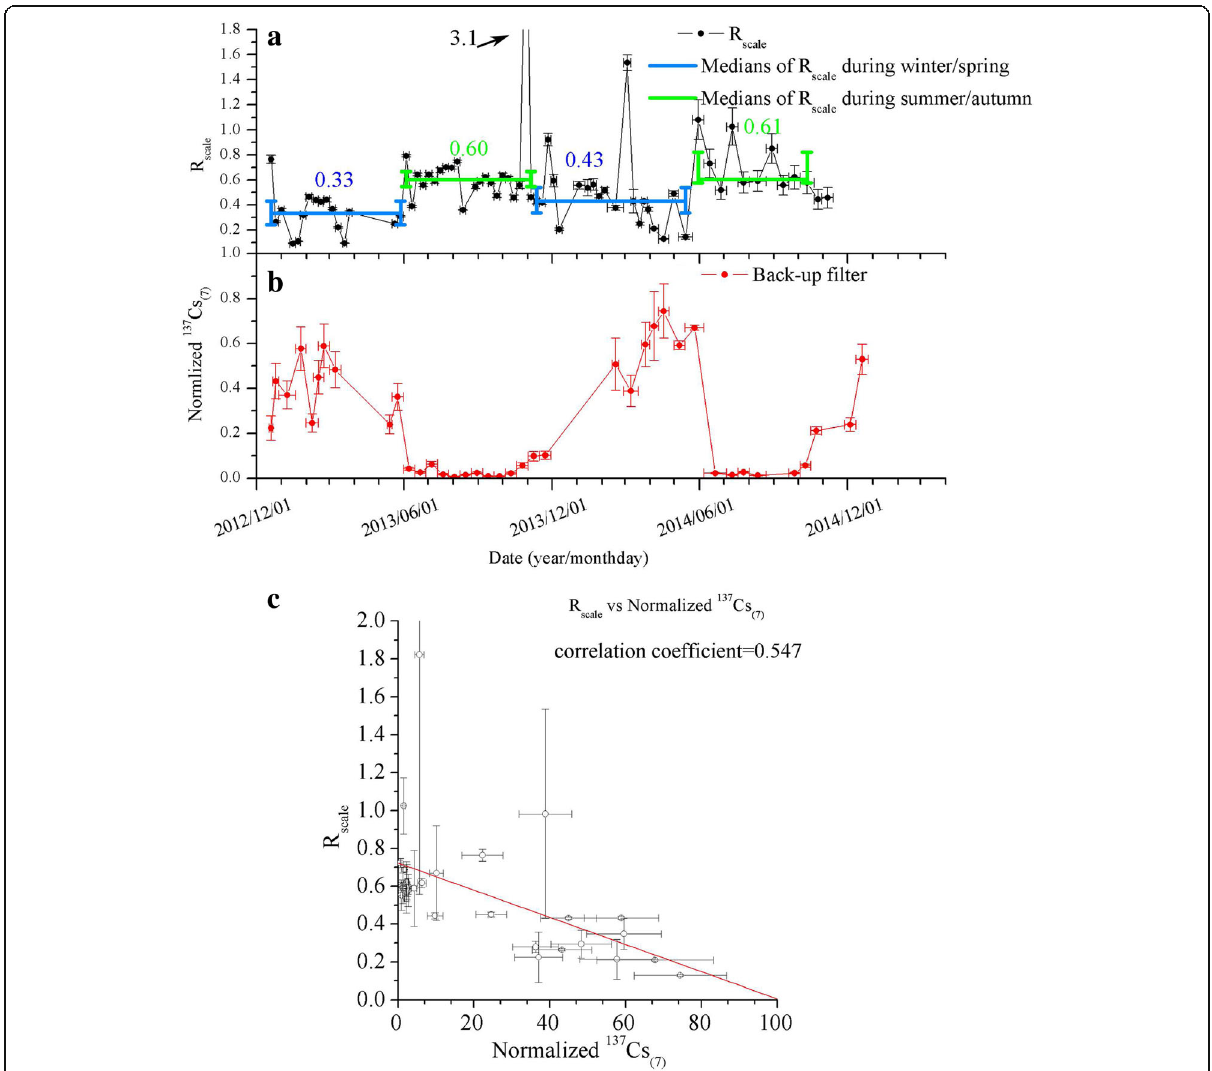
Fig. 7 Time series of a R scale and b normalized 137 Cs (7) at the GC site and c the correlation plot of R scale and the normalized 137 Cs (7) . Green and blue curves in a are the medians of R scale in summer/autumn and winter/spring, respectively. The error bars for each curve in a and b show the range of central